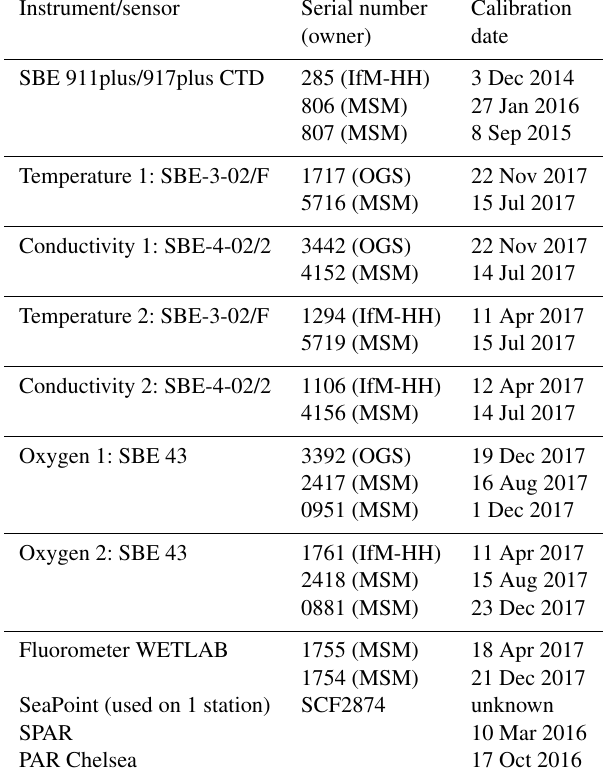
Table 2. Used CTD instrument and sensors. Owner of instruments are either the University of Hamburg, Germany (IfM-HH); the Na- tional Institute of Oceanography and Geophysics (OGS), Italy; or the property of the vessel Merian